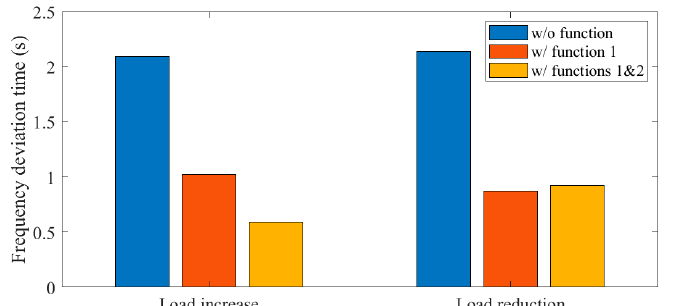
Figure 10. Time duration that frequency deviation from the nominal frequency 50 Hz is larger than 0.2 Hz.